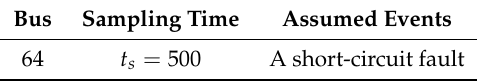
Table 2. A single event assumed in Case 1.